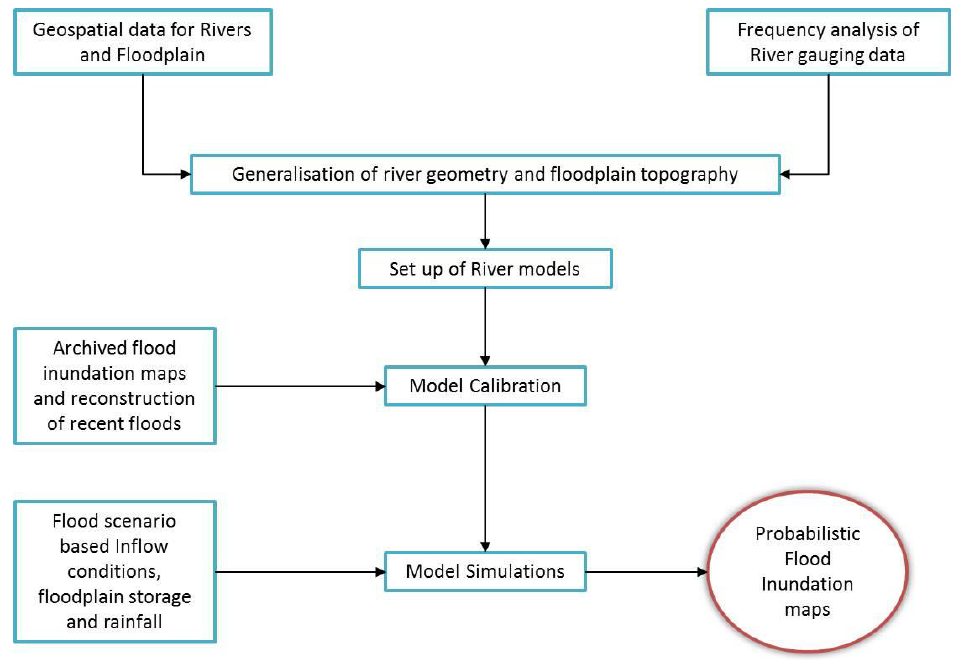
Figure 7. Hydro-informatics-based flood inundation modeling.